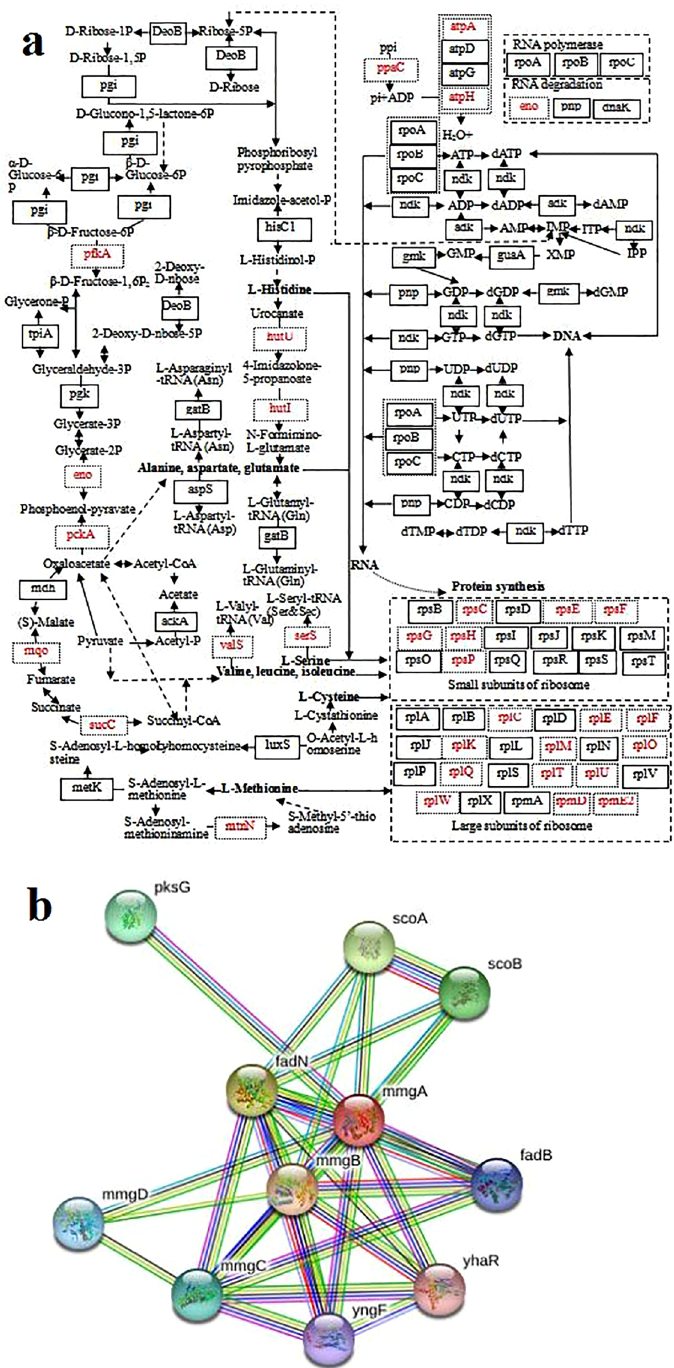
Figure 5. Analysis of the differentially expressed proteins detected by iTRAQ. ( a ) metabolic network regulated by up- and down-regulated synthesis proteins (genes with red dotted line: up-regulation); ( b ) protein network of acetyl-CoA acetyltransferase (medium confidence: